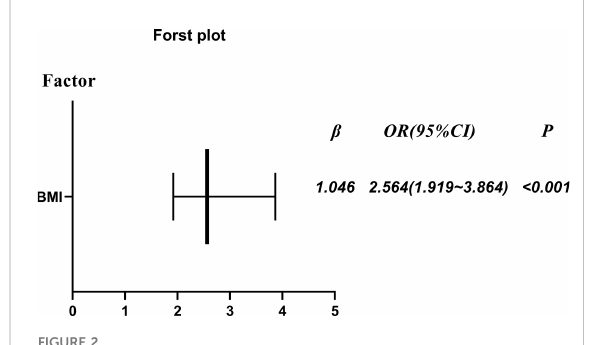
FIGURE 2 The rate of cesarean section (obese primiparous versus non- obese primiparous group) after adjustment for maternal age, GA, BMI, epidural analgesia, bishop score, birth weight and AFI.